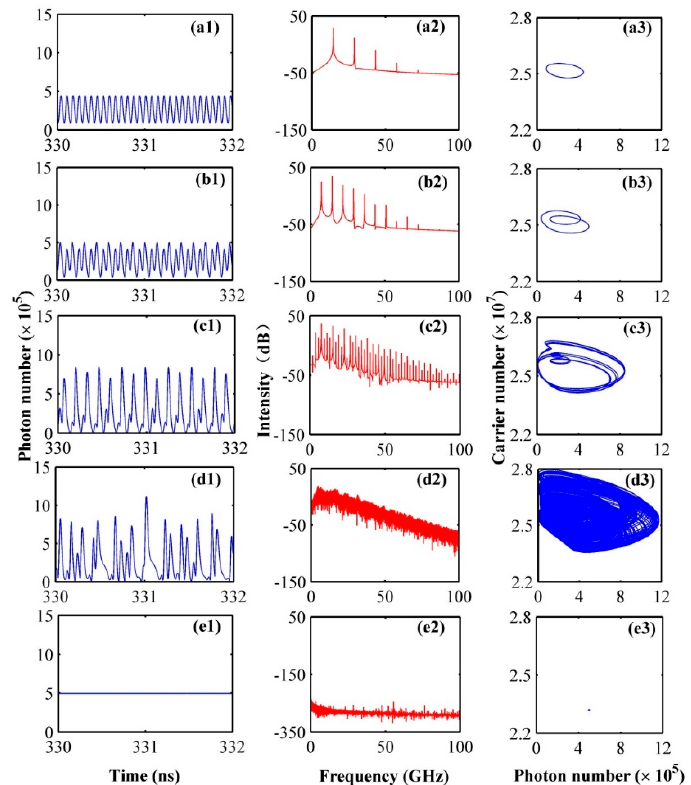
Figure 3. Time series (first column), power spectra (second column), and phase portraits (third column) of the ES-QD laser for ∆ ν = − 14.00 GHz and different K , where K = 0.30 (a1–a3), K = 0.33 (b1–b3), K = 0.49 (c1–c3), K = 0.64 (d1–d3), and K = 0.90 (e1–e3).